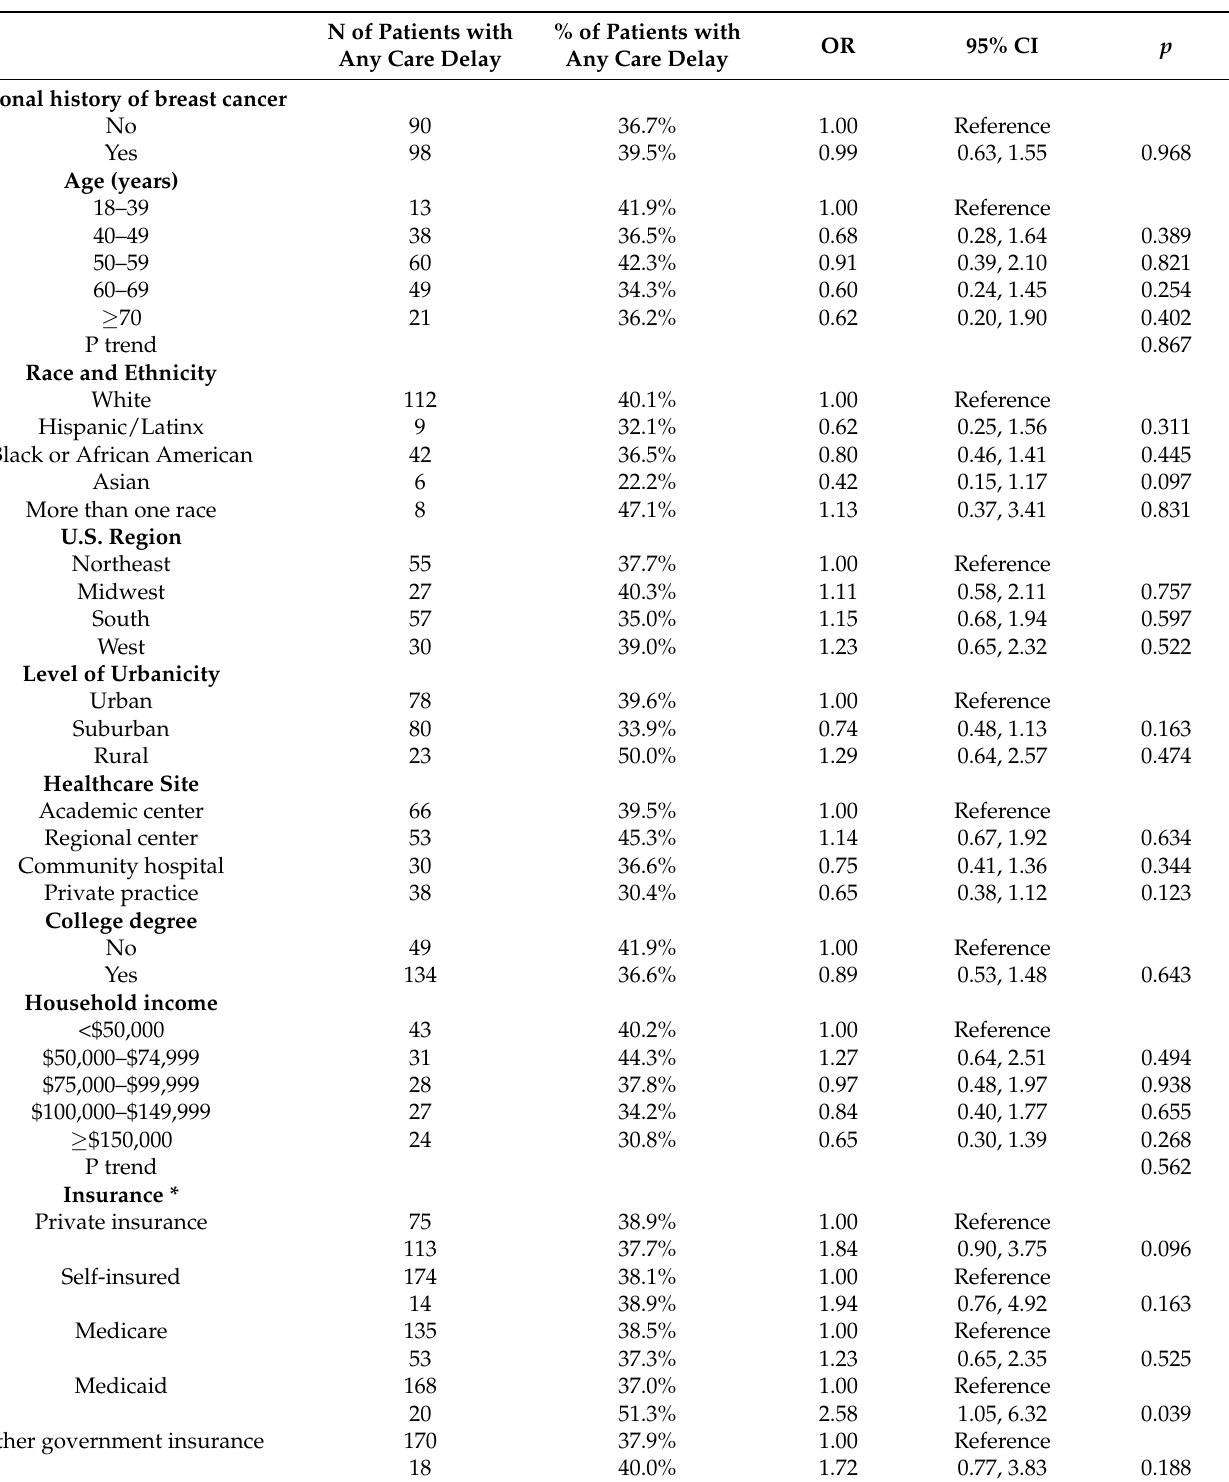
Table 2. Number, prevalence and adjusted odds ratio of COVID-19-related delay in care by sociode- mographic factors (n =